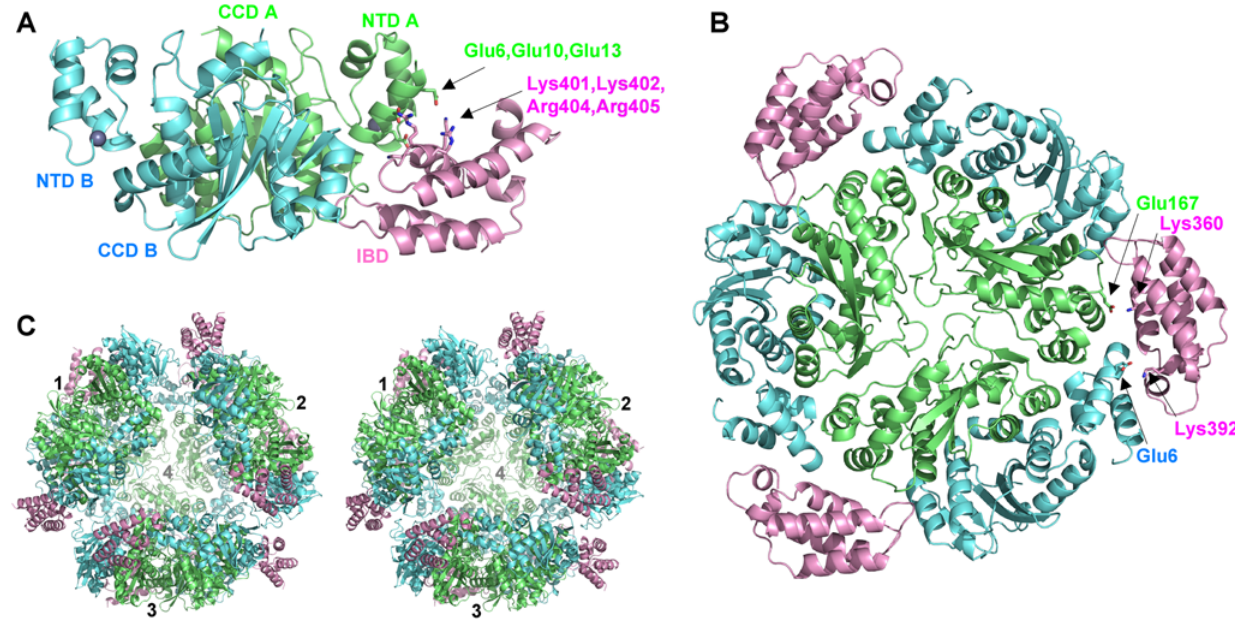
Figure 1. The HIV-2 IN NTD + CCD :LEDGF IBD Structure and Multimeric Assemblies Found in the Crystal. (A) The IN 2 LEDGF substructure, containing a dimer of IN NTD + CCD and a single molecule of LEDGF IBD , the basic building unit of both crystal forms. IN chains are colored pale green and cyan, and LEDGF is pink. Zinc atoms are shown as gray spheres. Residues involved in IN–LEDGF interfaces and discussed in the text are shown as sticks and indicated with arrowheads. (B) The closed trimer of IN 2 LEDGF substructures. Colors and labels as in (A). (C) Stereo view of the higher order assembly involving four IN 2 LEDGF trimers representing the entire ASU of crystal form II. Colors as in (A).